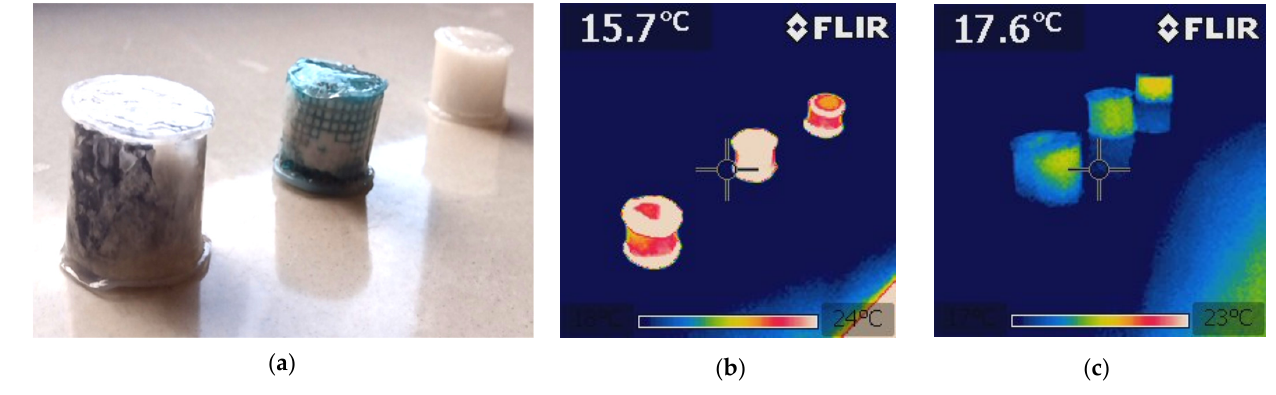
Figure 9. ( a ) Photographs of the test specimens of the three types of heat accumulators; ( b ) FLIR image with the heating of the three types of heat accumulators tested; ( c ) FLIR image with the cooling of the three types of heat accumulators tested.